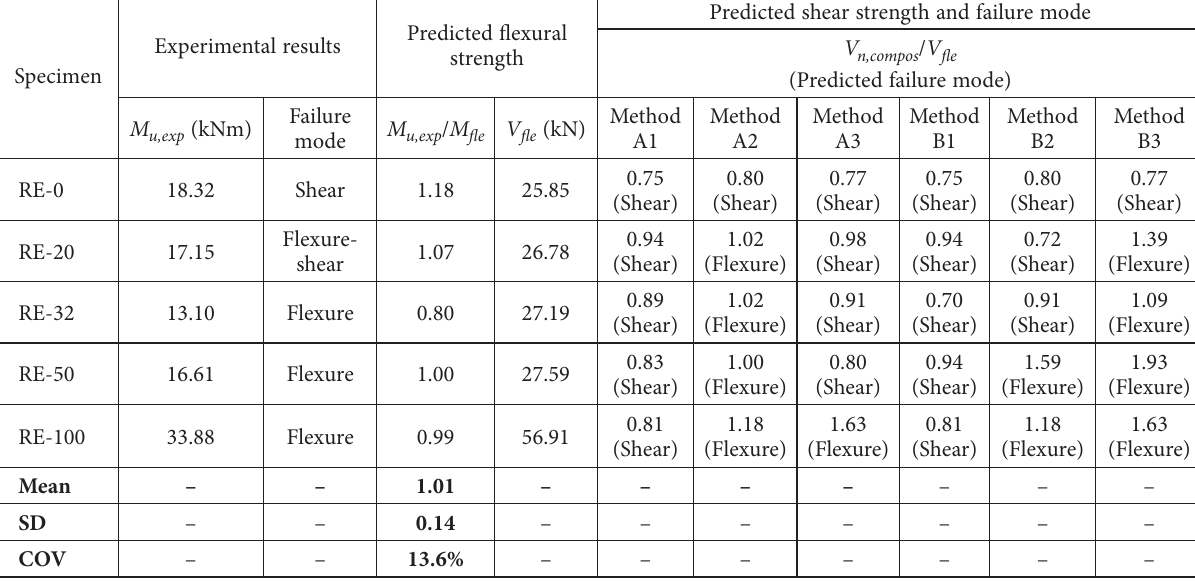
Table 5. Predicted failure modes for RE series specimens based on the previously computed flexural moment